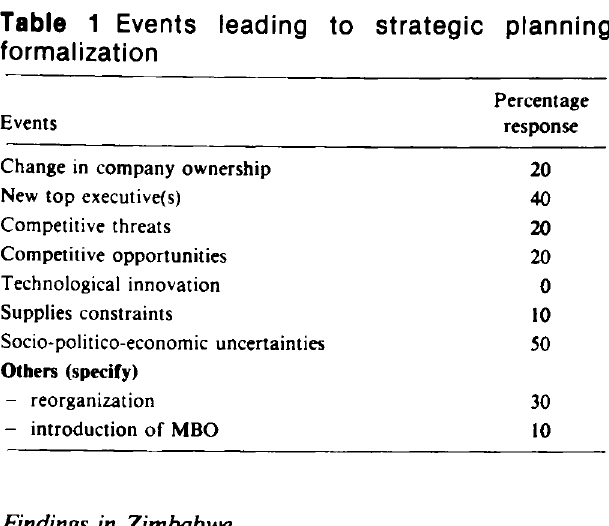
Table 1 Events leading to strategic planning